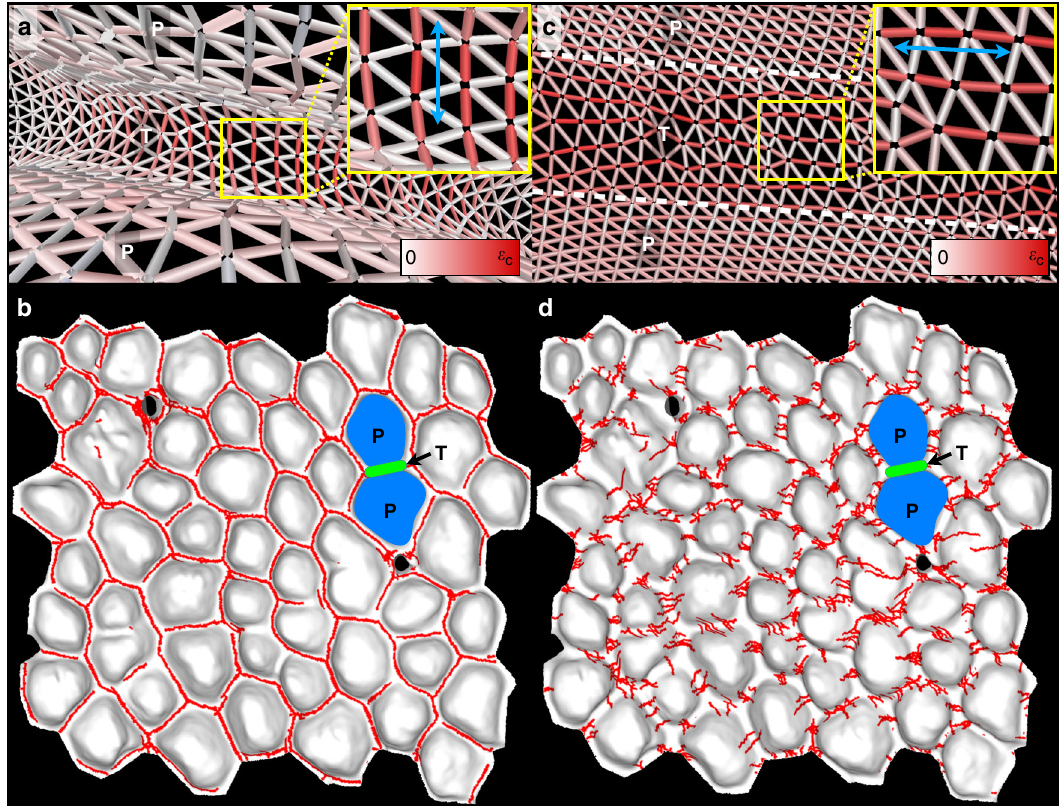
Fig. 4 Stratum corneum cracking by growth versus shrinkage. a , b Under the model of growth and de fi cient desquamation, addition of keratinous sheets at the curved stratum basale makes the outer sheets experience strong bending stresses perpendicular (blue double arrow in inset of a ) to the direction of troughs (T), causing cracks (red lines in b ) to propagate in-between papillae (P). c , d Conversely, simulation of stratum corneum desiccation results in a cracking pattern (red lines in d ) incompatible with those observed on elephants: simulated shrinkage makes the outer sheets experience stresses parallel (blue double arrow in inset of c ) to the direction of troughs (T), causing cracks (red lines in d ) to nucleate perpendicular to (rather than along) the trough directions, propagate over papillae (P) and not intersect at trough junctions. Mesh edges in a , c are coloured by the intensity of strain, from zero (white) to the critical strain ( ε c , saturated red) at which edges are broken. Results shown are for ε c = 0.3 and h /< d > = 1/6 ( < d > = average trough spacing), at a stage when ~3% of the mesh edges are